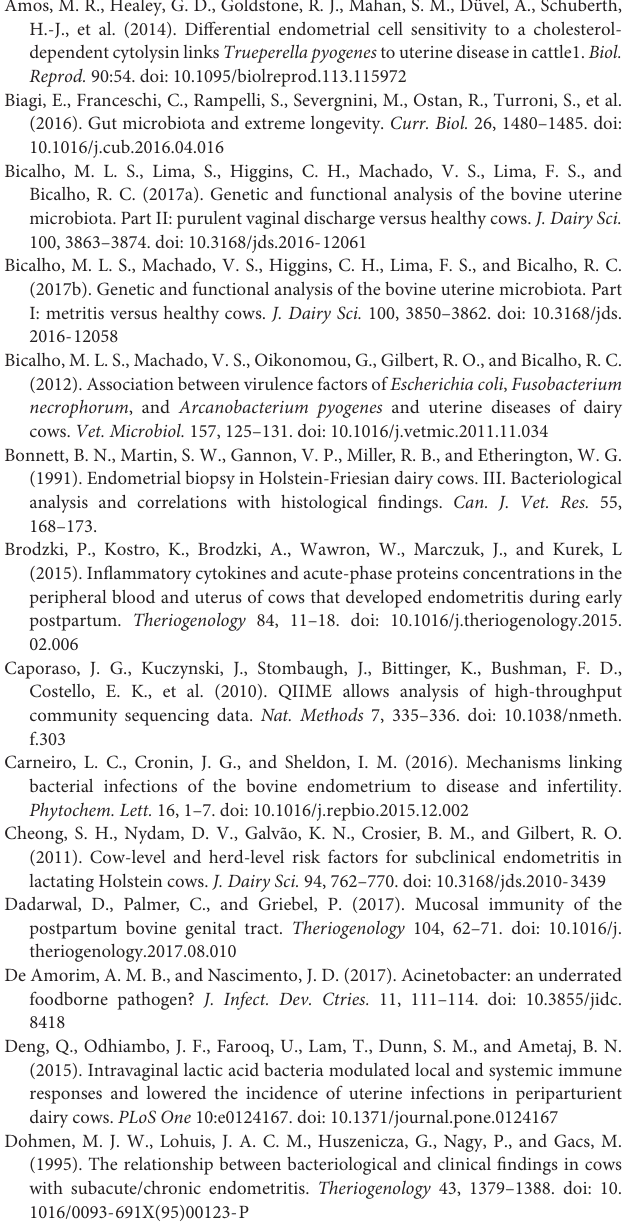
TABLE S4 | Relative abundance of the 28 most abundant genera detected in the uterine of postpartum healthy and endometritic dairy cows at 30 days postpartum. TABLE S5 | Relative abundance of 28 most abundant species detected in the uterine of postpartum healthy and endometritic dairy cows at 30 days postpartum. TABLE S6 | Correlations among the 28 most abundant genera detected in the uterus of 27 cows at 30 days post parturition. Only significant ( P < 0.05) Spearman coefficients of correlation are